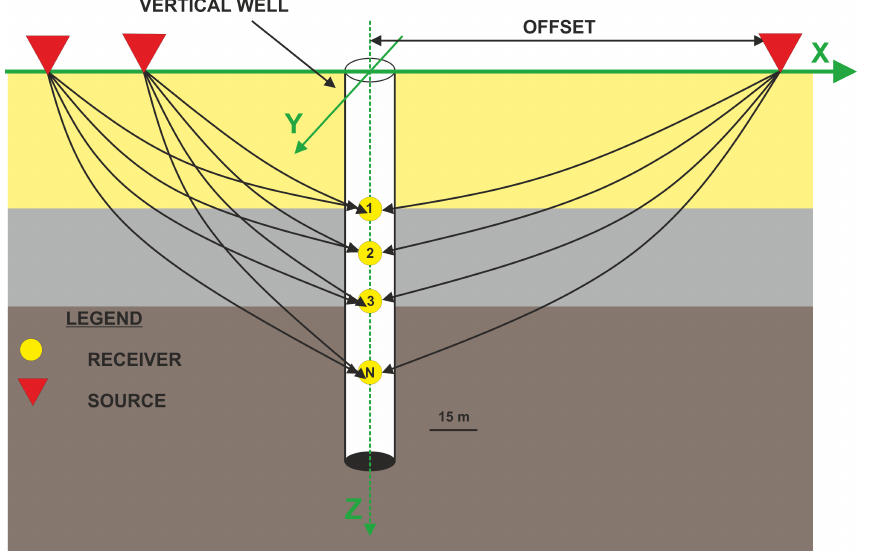
Figure 2. Walkaway VSP